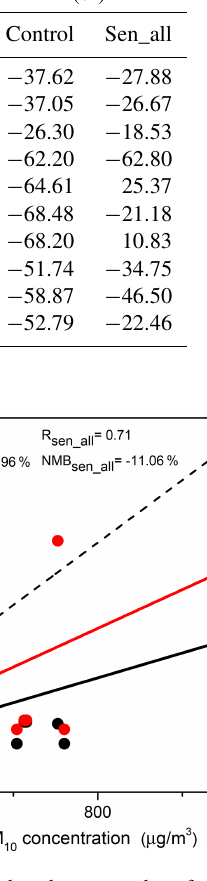
Figure 10. Comparison of modeled and measured surface PM 10 concentrations at observational sites. The dotted line is the 1 : 1 line. Model results are taken from the control run and Sen_all re-